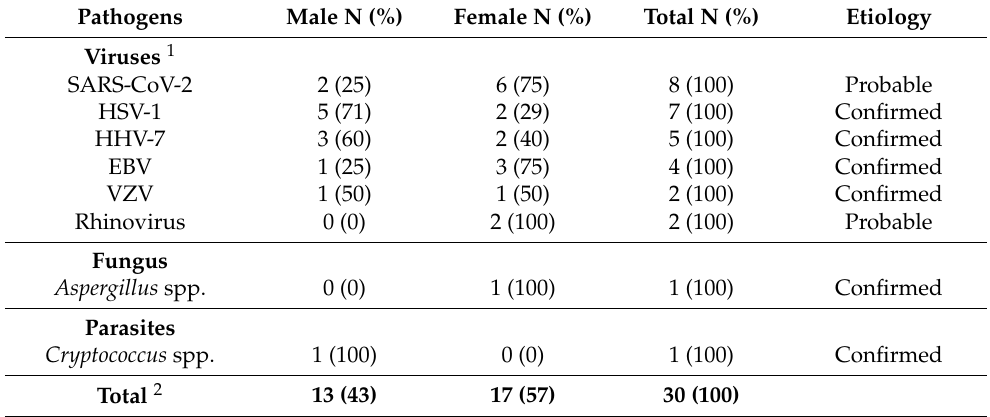
Table 3. Pathogens detected in encephalitic patients according to sex, Dakar, January–December 2021.